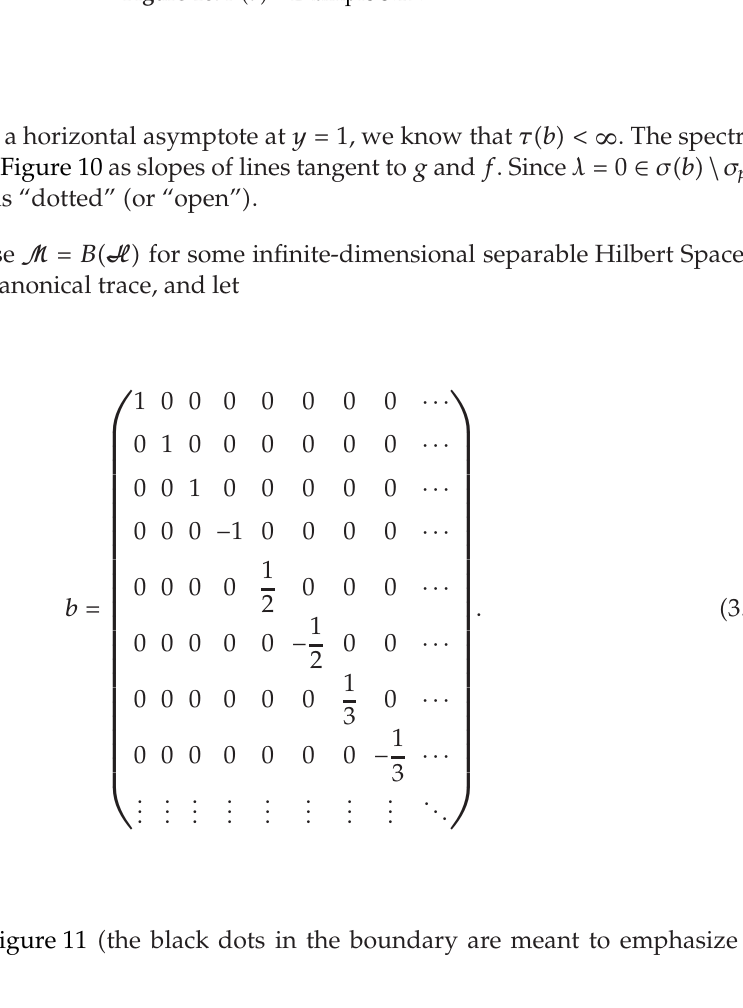
Figure 10: B (cid:2) b (cid:3) —Example